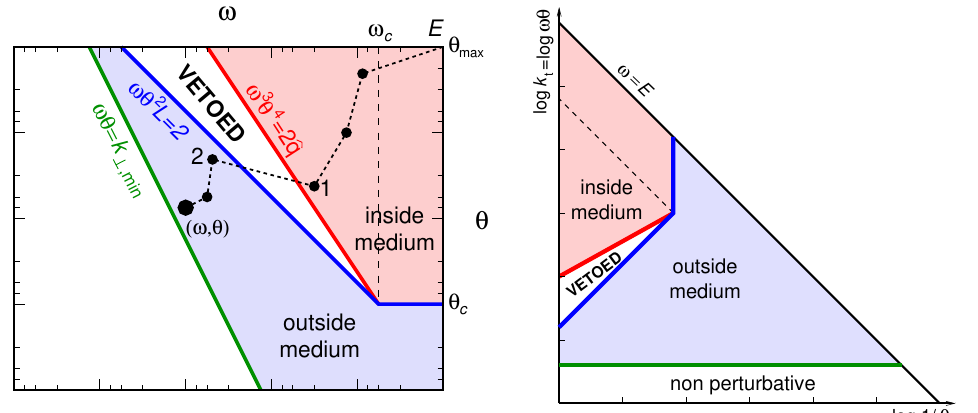
Figure 1 . The phase-space for vacuum-like gluon emissions by a jet propagating through a dense QCD medium, in logarithmic units. In the left plot, the variables are the gluon energy ! and its emission angle (cid:18) . In the right plot, we rather use the relative transverse momentum k ? ’ !(cid:18) and the inverse of the angle 1 =(cid:18)